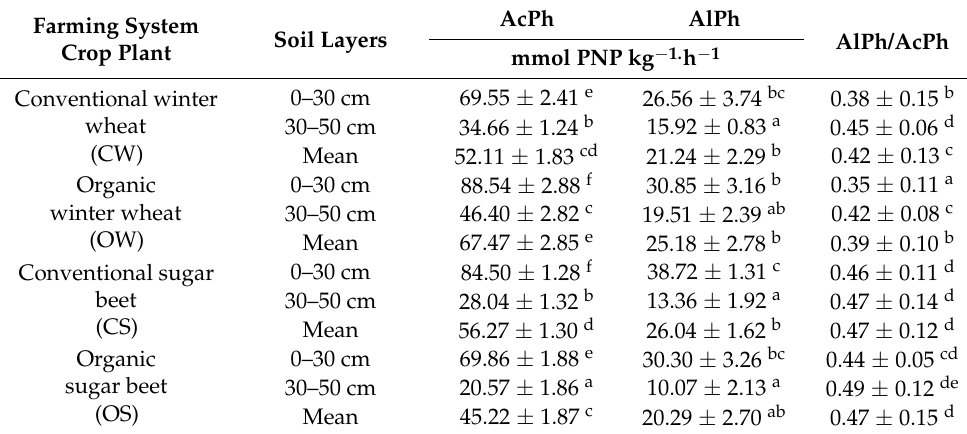
Table 8. Effect of the interaction of the experimental factors on the activity of acid and alkaline phosphatase and AlPh/AcPh ratio.